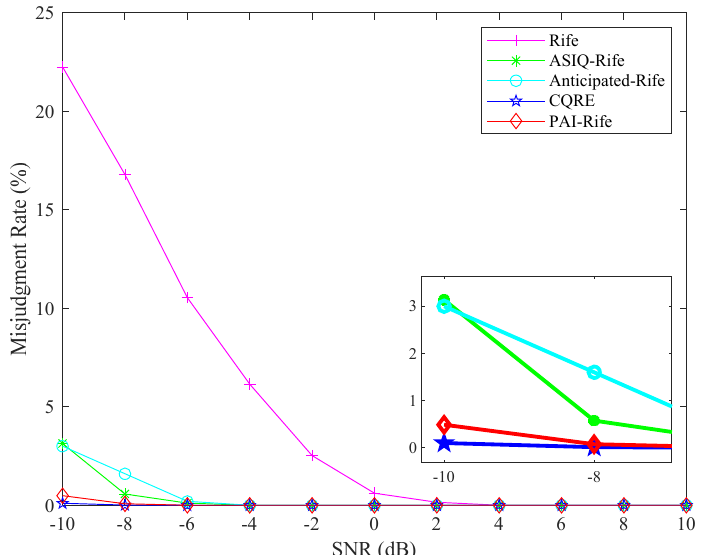
Figure 10. Correction misjudgment rates of several Rife algorithms under different SNRs.